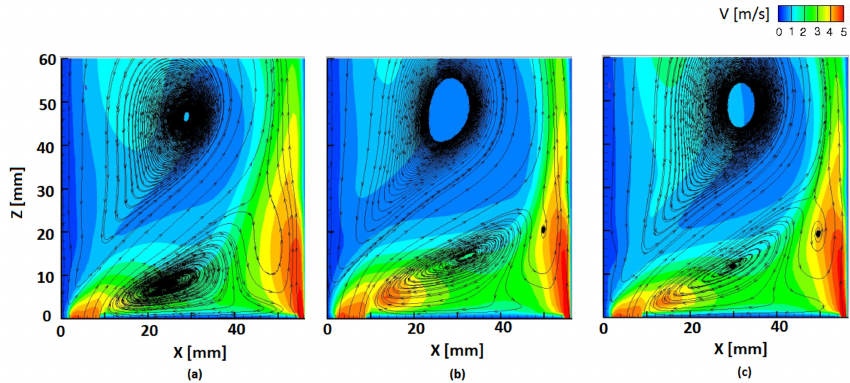
Figure 14. Flow comparisons-tangential velocity profile shown for the combustion model ED and different turbulence models: ( a ) RNG k- (cid:101) , ( b ) k- ω and ( c ) SST.